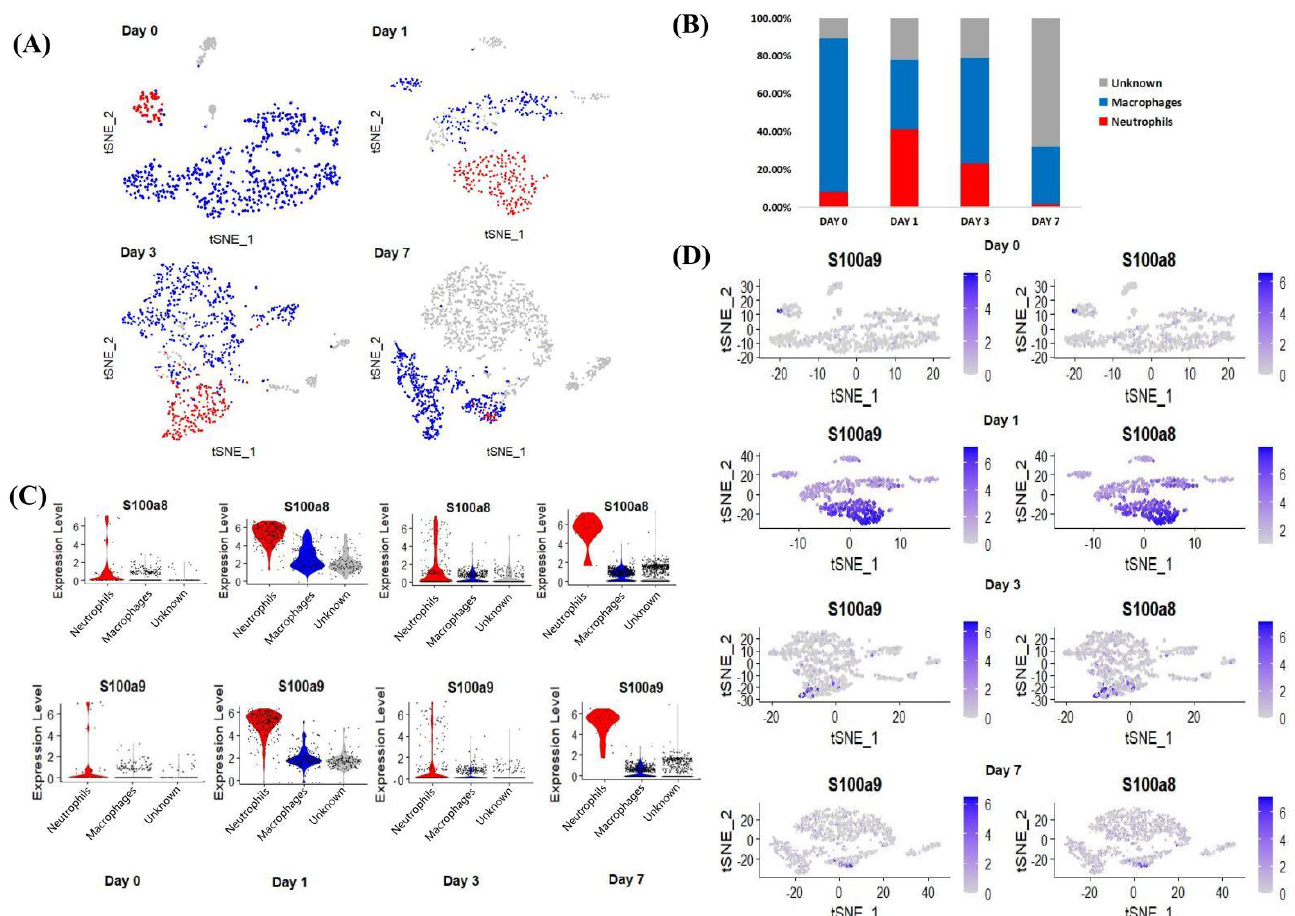
Figure 3. Cluster analysis of scRNA-seq data. ( A ) The classification of cardiac CD45+ total leukocytes from day 0 to day 7, using t-distributed random neighbor embedding, and coloring by clustering after manual annotation. Blue (macrophages), red (neutrophils), gray (unknown). ( B ) The proportion of neutrophils, macrophages and unknown clusters among the total number of cells at each time point. ( C ) Violin diagram of the expression of S100a8 and S100a9 in various types of cells at each time point. ( D ) S100a8 and S100a9 expression distribution map at each time point.